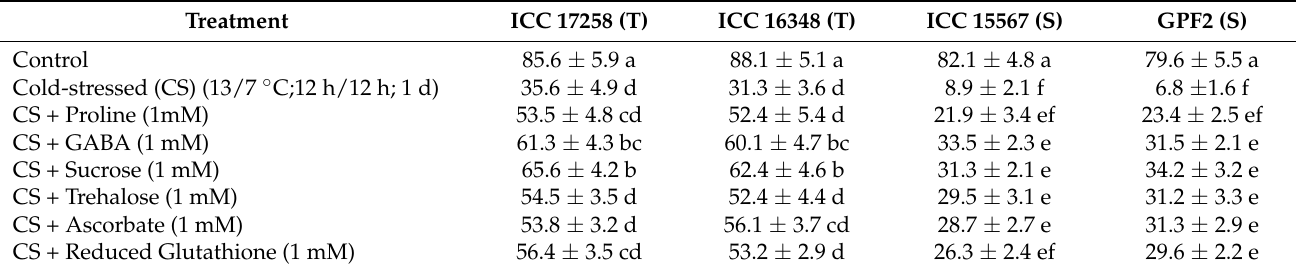
Table 1. Effect of various solutes and non-enzymatic antioxidants on pollen germination under cold stress in tolerant (T) and sensitive (S) chickpea